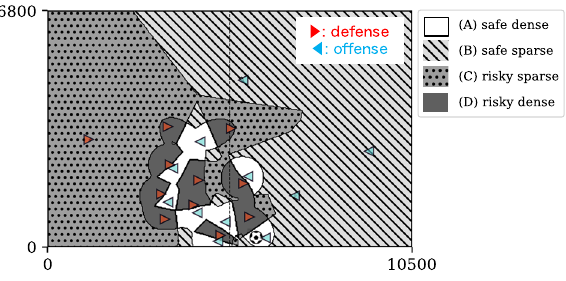
Figure 5. Typical example of field division into the following four spaces: (A) safe dense space ( z 1 > 0 and z z z z z 2 < 2 ), (B) safe sparse space ( 1 > 0 and 2 > 2 ), (C) risky sparse space ( 1 < 0 and 2 > 2 ), and (D) risky dense space ( z 1 < 0 and z 2 < 2 ). The players in the offense (i.e., ball-possession team) and defense teams are shown via blue leftward and red rightward triangles, respectively. The player on the right side near the halfway line has the ball. In order for this player to execute a shot from this location, the ball has to be sent to a space in front of the opponent’s goal; however, this space is risky because it corresponds to (C) or (D).